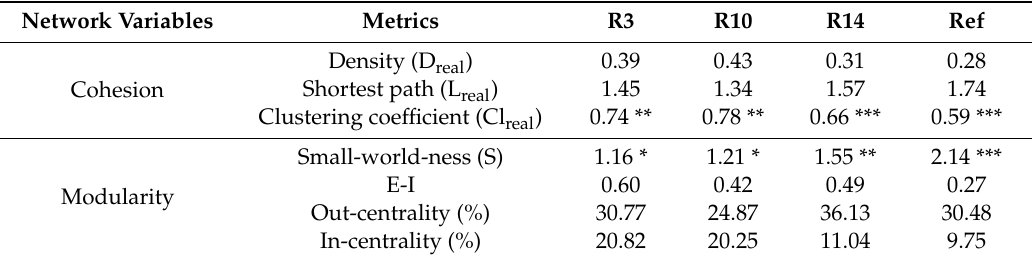
Table 3. Network parameters in the three reclaimed sections (R3, R10 and R14) and references sites (Ref). Stars show significant di ff erences compared to corresponding average estimations made in 999 random networks with the same number of links. *** p < 0.001, ** p < 0.01, * p < 0.05.